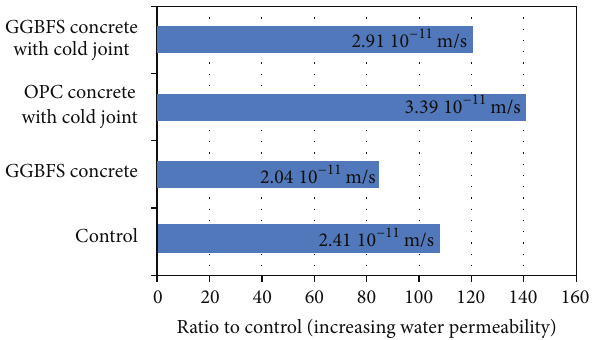
Figure 11: Ratios of water permeability to control